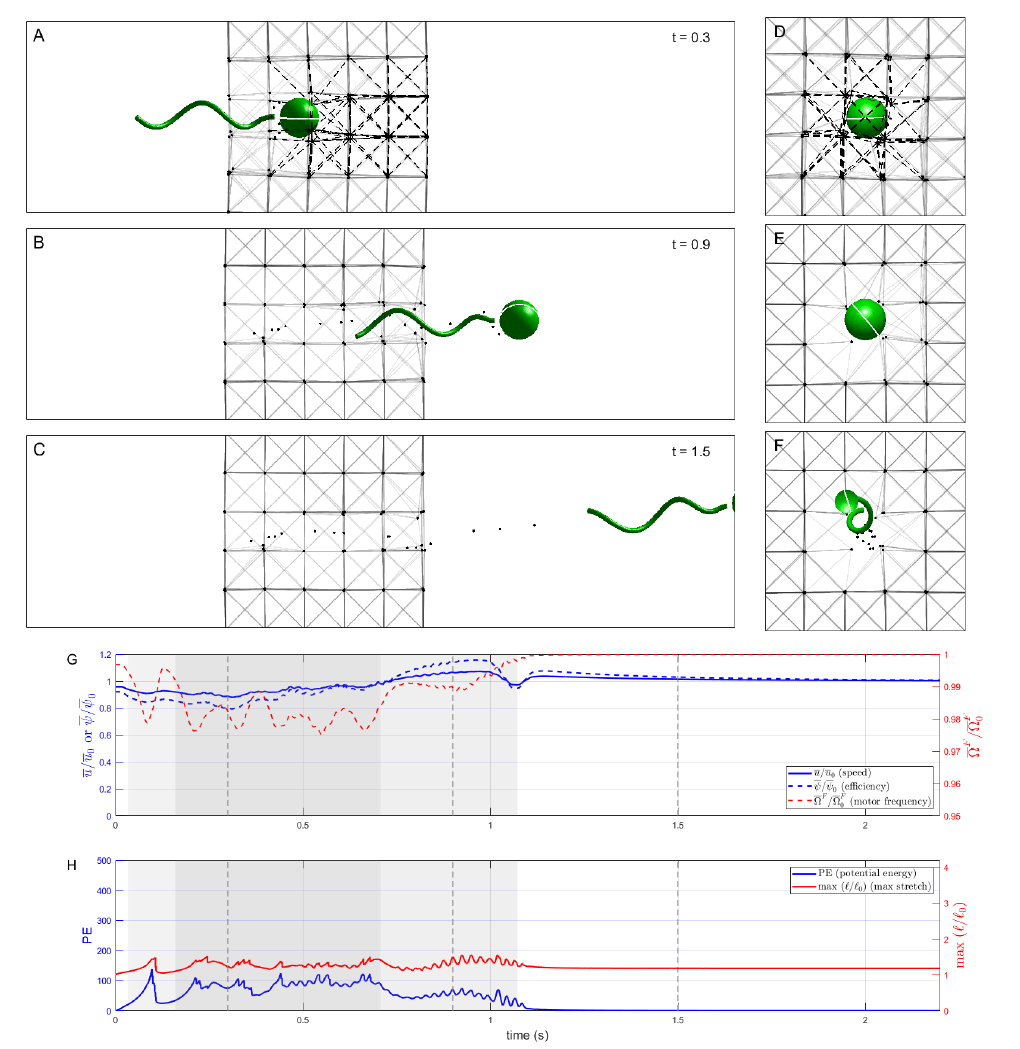
Figure 7. Summary of results for E = 25 mPa, η = 10 mPa-s in which network links coming within 0.2 R S of the body surface were permanently destroyed, modeling chemical degradation. See Figure 3 for panel descriptions, but note that panels for t = 2 s are omitted because the swimmer has completely exited the field of view at that time. See in Supplementary Materials Video S4 for an animated